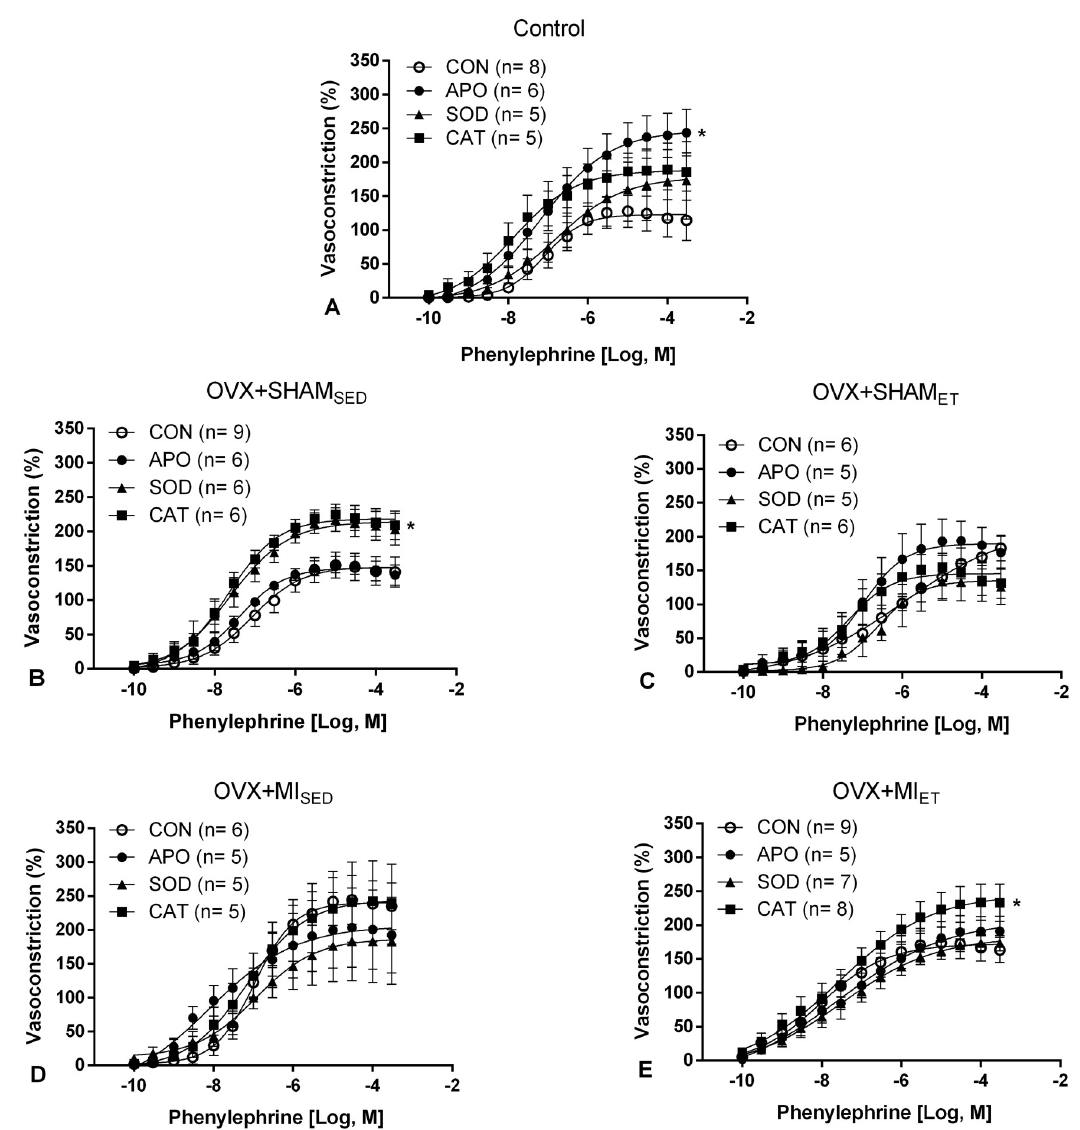
Fig 3. Concentration-response curves to phenylephrine after incubation with apocynin, SOD, and catalase in isolated aortic rings. Data are expressed as mean ± standard error of the mean (SEM); Two-way ANOVA was used followed by the Dunnet post-hoc test for comparisons with the control group curve � p < 0.05 vs